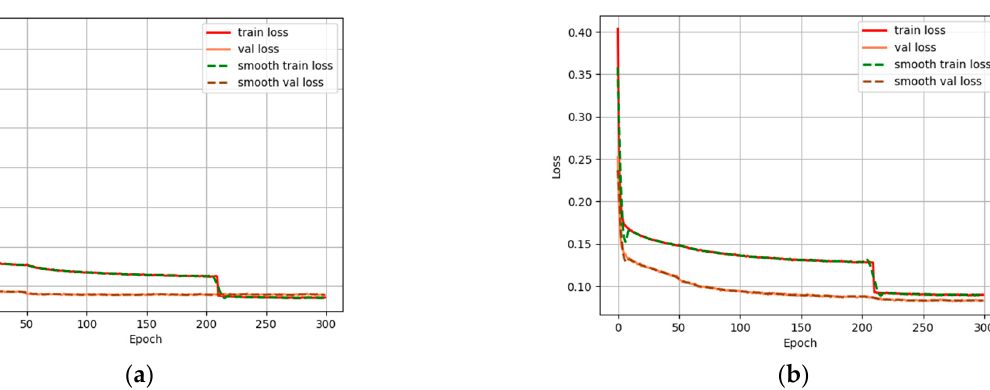
Figure 11. Comparison of different models’ training loss function. ( a ) ST-YOLOv5 model training loss function. ( b ) YOLOv5 model training loss function.